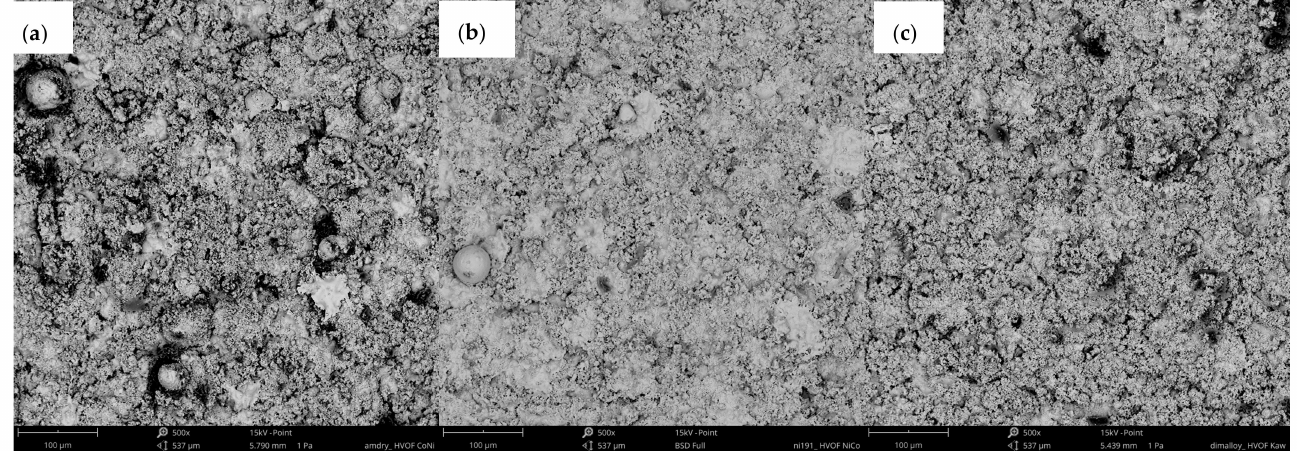
Figure 3. Surface morphology of as-sprayed coatings: ( a ) CoNiCrAlY; ( b ) NiCoCrAlY and